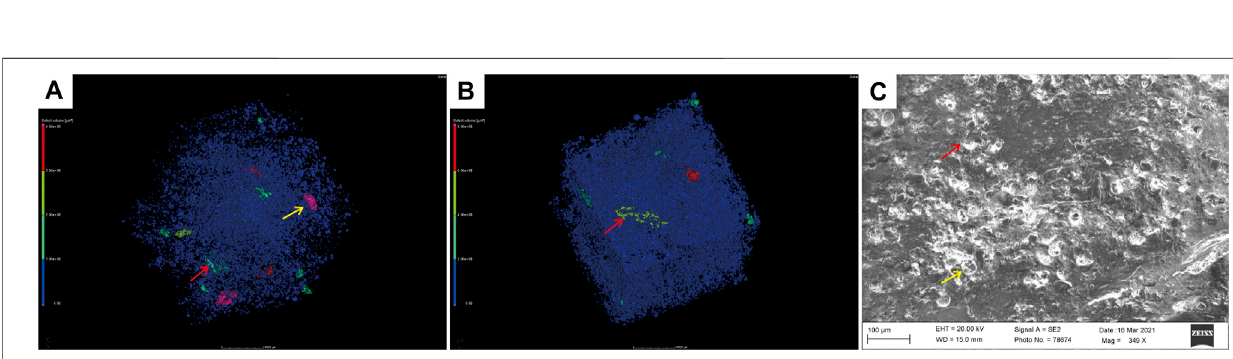
FIGURE8|(A) SiteW19,146.35mbsf,CTscanimage; (B) SiteW19,156.55mbsf,CTscanimage; (C) SiteW19,146.35mbsf,SEMimage; (D) SiteW19,156.55 mbsf, SEM image; red arrows indicate CG-intergranular pores, yellow arrows indicate BG-pores.